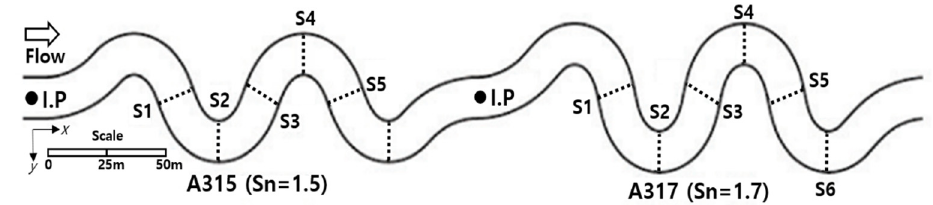
Figure 4. Plan view of mid-scale nature-like channel in Andong River Experiment Center in Korea (adapted from Shin et al. [37]).